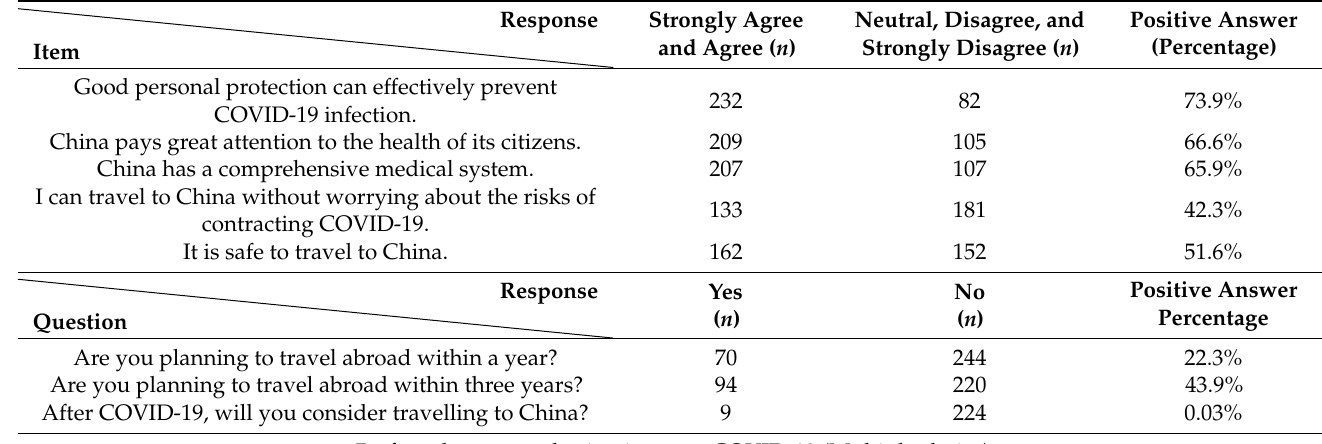
Table 2. Excerpt of the results of the survey questionnaire ( n =